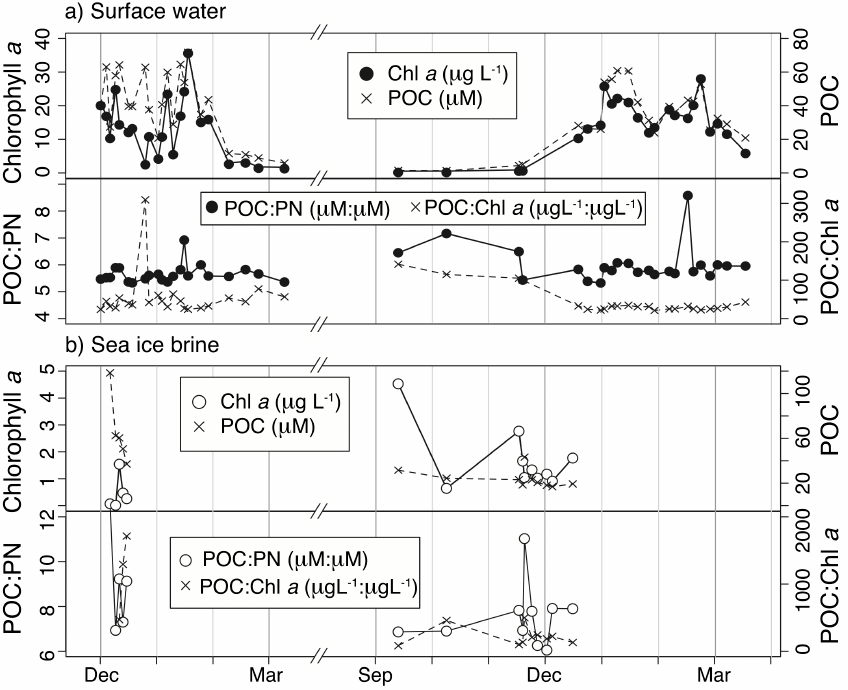
Fig. 4. Time series plots of chlorophyll a concentration, POC concentration, POC:PN and POC:chl a in (a) surface water and (b) sea ice from December 2004 to April